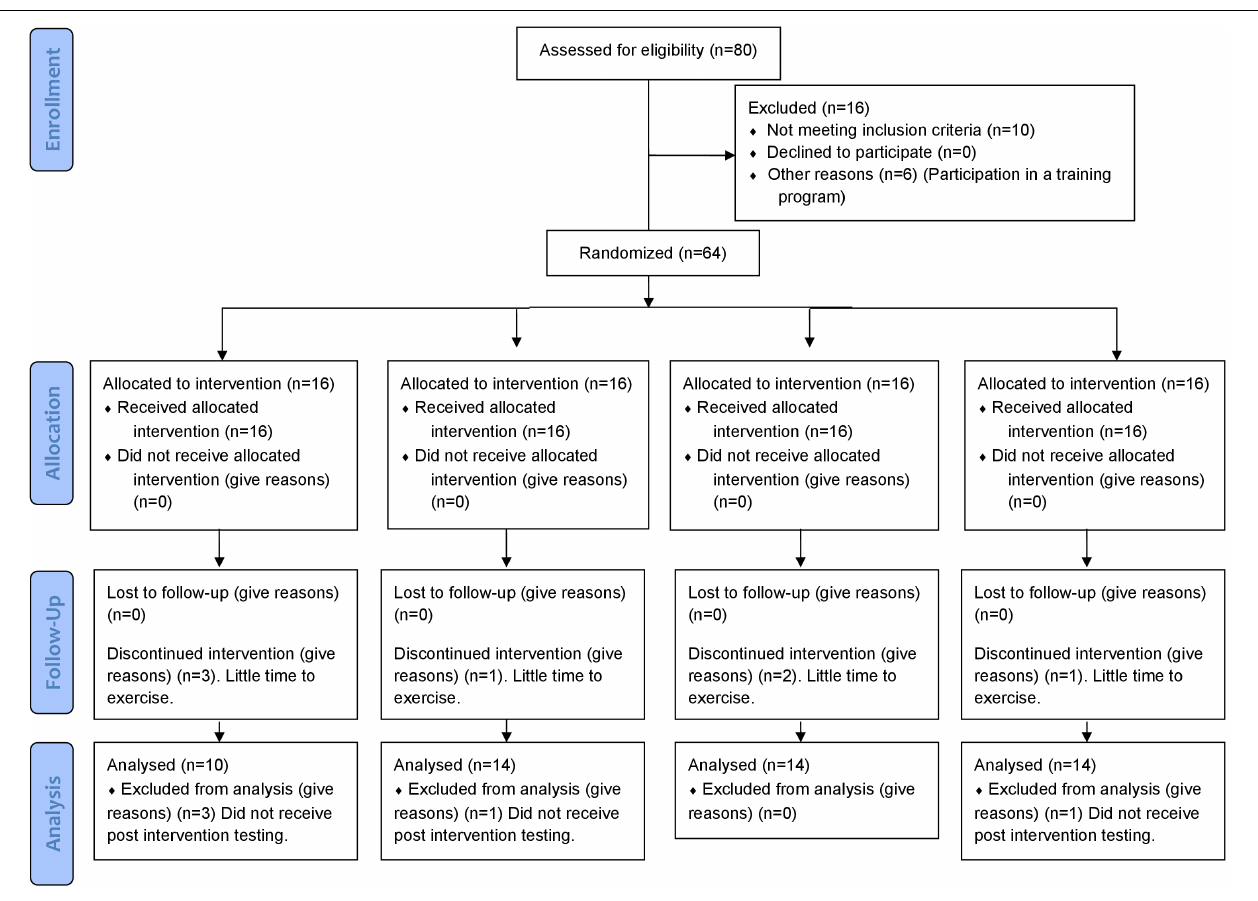
FIGURE 1 | CONSORT flowchart of the study.